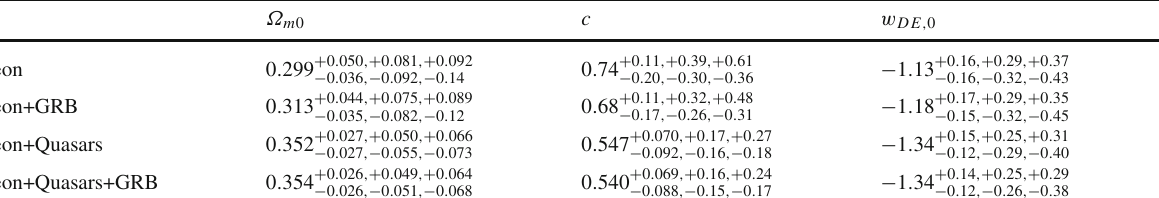
Table 1 The best-fit values of the cosmological parameters Ω m 0 , c and w DE , 0 within the 1 − σ , 2 − σ and 3 − σ uncertainties using the Hubble diagram data from Pantheon, quasars and GRB